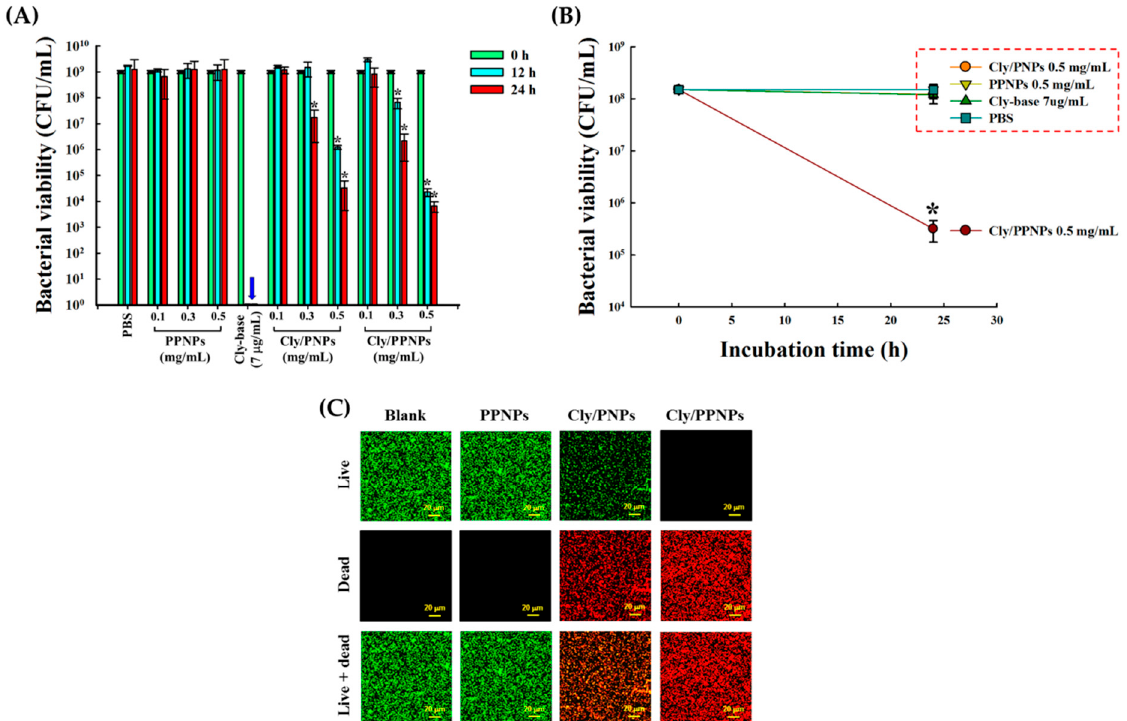
Figure 4. Antibacterial activity of PPNPs, Cly/PNPs, and Cly/PPNPs against MRSA. ( A ) The mean number of CFUs ± SD ( n = 3). The blue arrow at Cly-base shows no viable bacteria (0 CFU/mL). ( B ) The effect of binding on bacterial viability after treatment with or without Cly-base, PPNPs, Cly/PNPs, and Cly/PPNPs, followed by washing. The red box indicates a group of samples that have no antibacterial activity. ( C ) Confocal microscopy images after 24 h of treatment with NPs at 0.5 mg/mL. Syto-9 fluorescence (green) represents the intact membrane of live bacteria, PI fluorescence (red) represents membrane destruction and cell death. Blank is the control group (PBS alone). Bars represent 20 μ m.